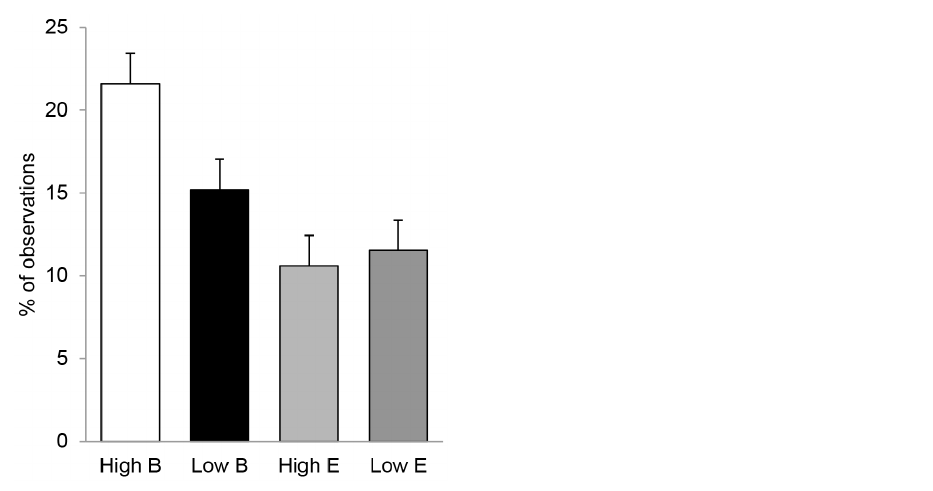
Figure 5. Genotype-environment interaction. Percentage of observations that a pig was lying in body contact with the familiar pig, given for pigs which were genetically selected for either high or low IGEg, and housed in barren (B) and enriched (E)